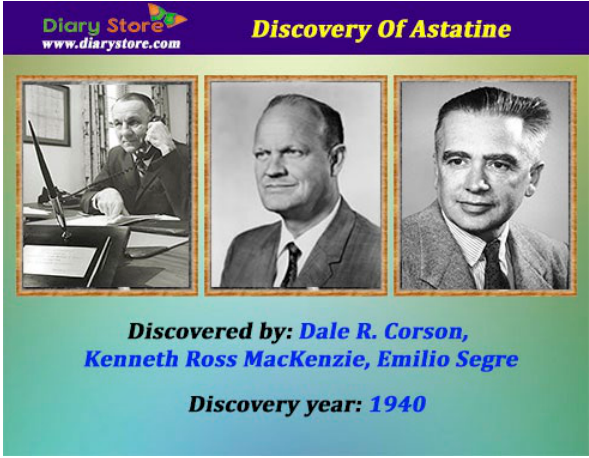
Figure 1. An announcement of the discovery of the element asta-